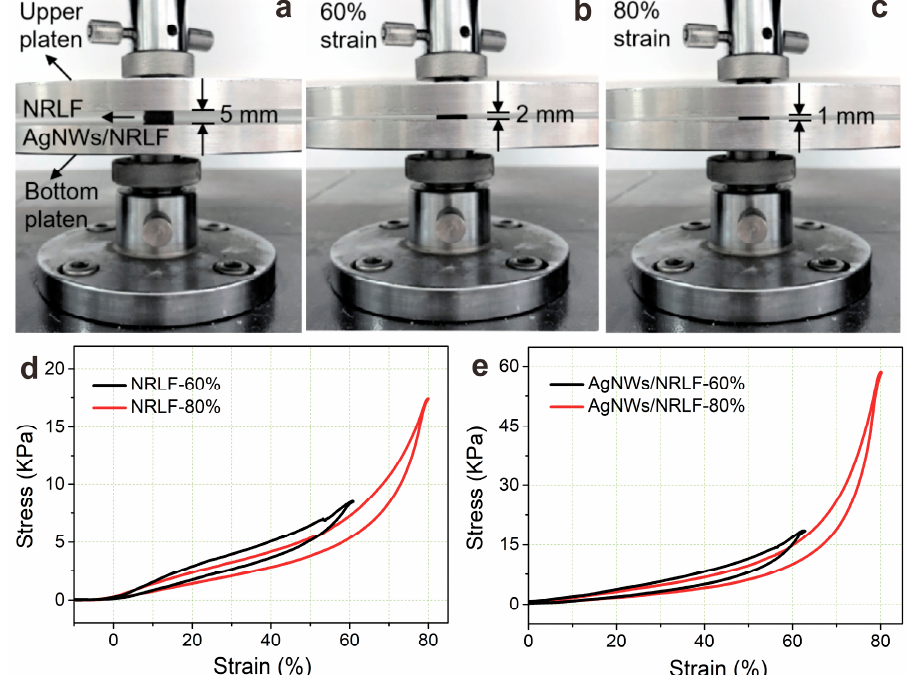
Figure 5. ( a ) the compressive testing system and NRLFs/AgNWs/NRLFs. ( b , c ) compressive strains of 60%, 80%. ( d , e ) compressive stress variation of NRLFs and AgNWs/NRLFs with different compressive strain amplitude.